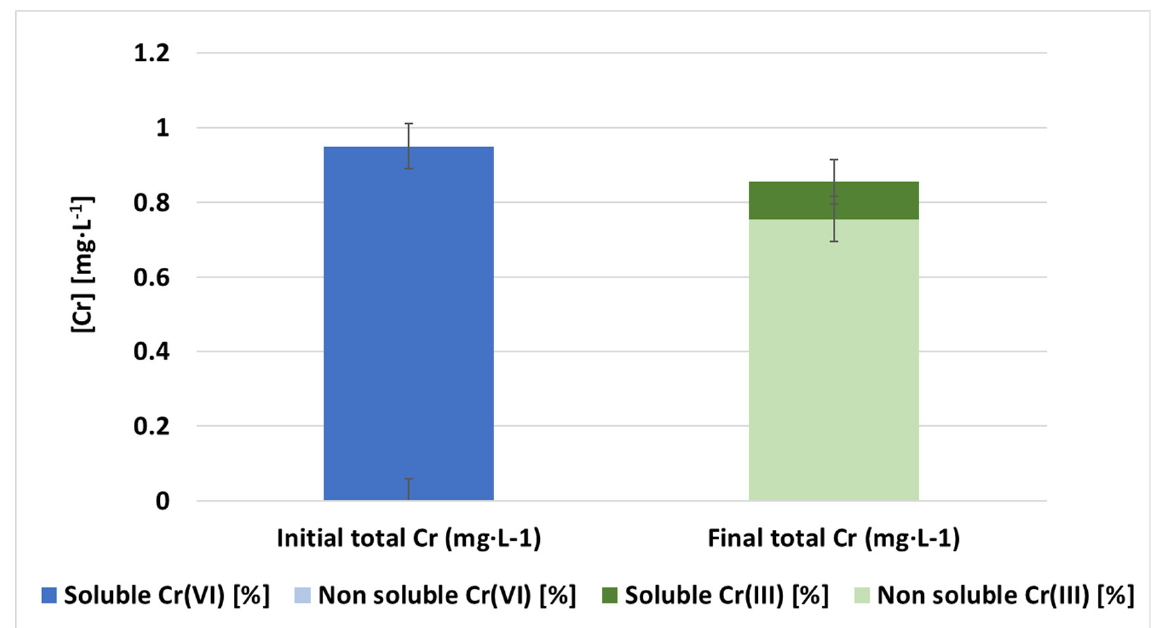
Figure 9. Initial and final concentrations of hexavalent and trivalent chromium in soluble and non- soluble fractions of treated water during adsorption batch experiments with CCNC for 24 h under pH 3, 100 mg·L −1 of adsorbent dosage and 1 mg·L −1 of initial hexavalent chromium concentration.